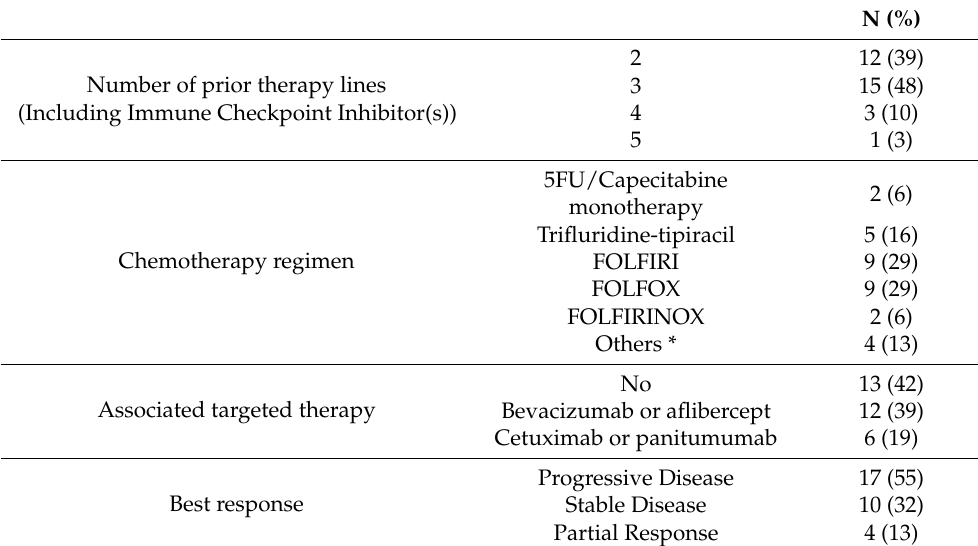
Table 2. Characteristics of and outcomes with post-Immune Checkpoint Inhibitor(s) chemotherapy ± targeted therapy.